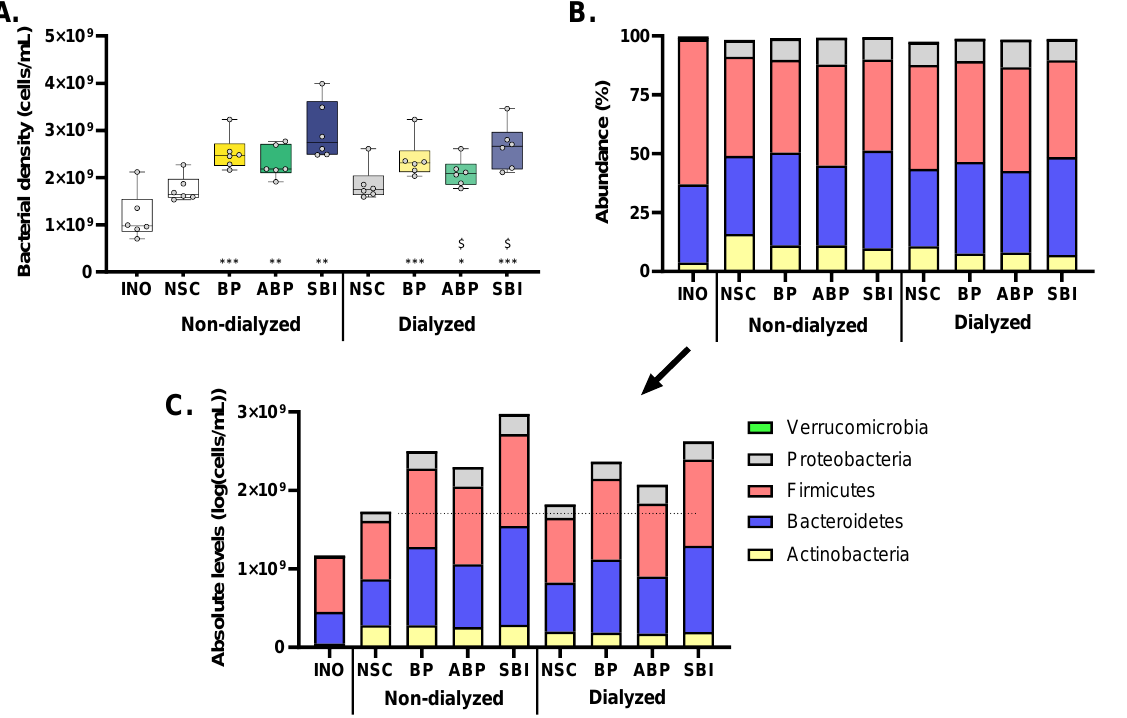
Figure 2. Three bovine plasma protein fractions (BP, ABP and SBI) stimulated growth of hu- man adult gut microbiota ex vivo. ( A ) Bacterial cell density of microbial communities derived from human adults ( n = 6) as tested via the ex vivo SIFR ® technology (cells/mL). Three protein bovine plasma fractions (BP/ABP/SBI) were tested at a dose equivalent of 5 g/day, with or with- out prior dialysis, simulating absorption in the small intestine, compared to a NSC. Samples were collected after 0 h (INO) and 48 h of simulated colonic incubations. Statistical differences between treatments and the NSC are indicated with * (0.01 < p adjusted < 0.05), ** (0.001 < p adjusted < 0.01) or *** ( p adjusted < 0.001), while differences between protein fractions ABP/SBI and fraction BP are indi- cated with $ (0.01 < p adjusted < 0.05). The microbial composition (phylum level) in samples collected after 0 h (INO) and 48 h of simulated colonic incubations, presented both as ( B ) proportional (%) and ( C ) absolute values (cells/mL), as averaged across the six human adults tested. BP = bovine plasma, ABP = albumin-enriched bovine plasma, SBI = serum-derived bovine immunoglobulin, SIFR = systemic intestinal fermentation research, and NSC = no substrate